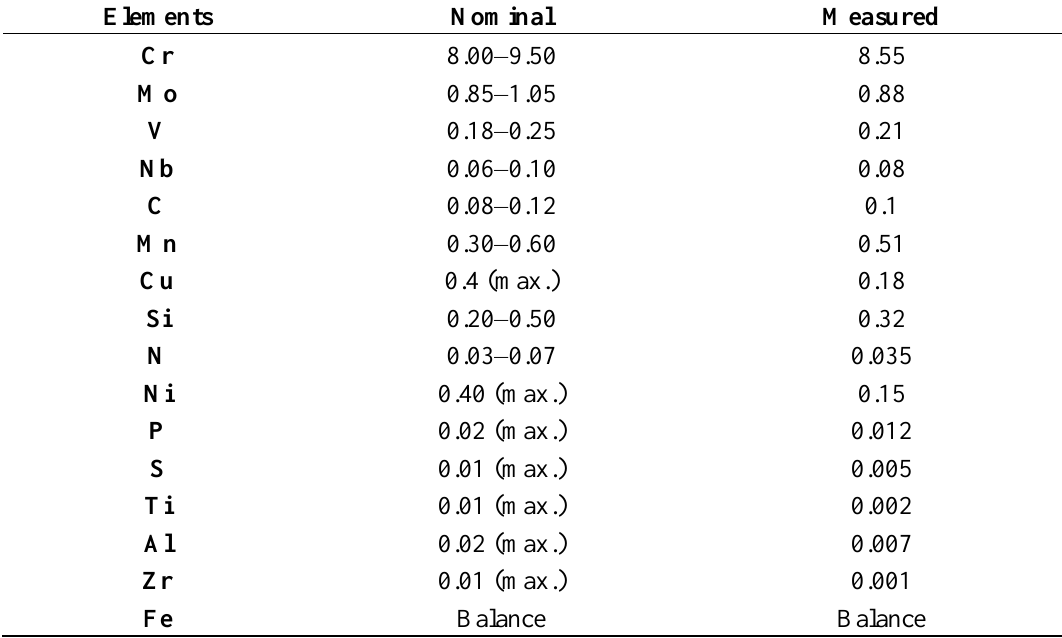
Table 1. Chemical composition (wt. %) of modified 9Cr-1Mo steel.